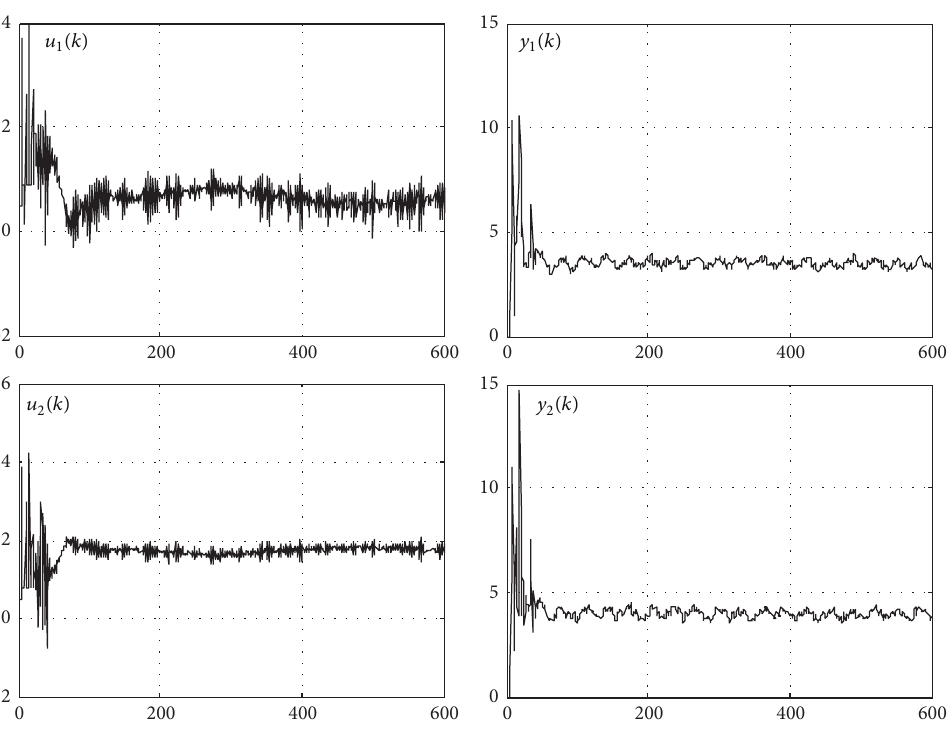
Figure 7: Evolution curves of the outputs variances 𝜎 2 𝑦